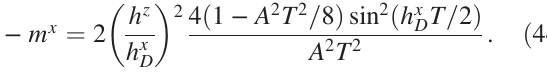
FIG. 4. Interacting case: Freezing and resonances in the magnetization ratio m x [panels (a,b)] and high temperature (inverse temperature β ¼ 10 − 2 ) [panel (c)], and other parameters are as described in Fig. 1(a). Results shown for slow [(a) ω ¼ 0 . 4 ] and very slow [(b,c) ω ¼ 0 . 04 ] drives (points on the green lines). The resonances obtained from first-order FDPT, Eq. (42) (purple vertical lines), show a remarkable match with the numerical values of dips in m x . [Some higher-order resonances are also visible at ω ¼ 0 . 4 in panel (a)]. The other parameters are the same as in Fig.